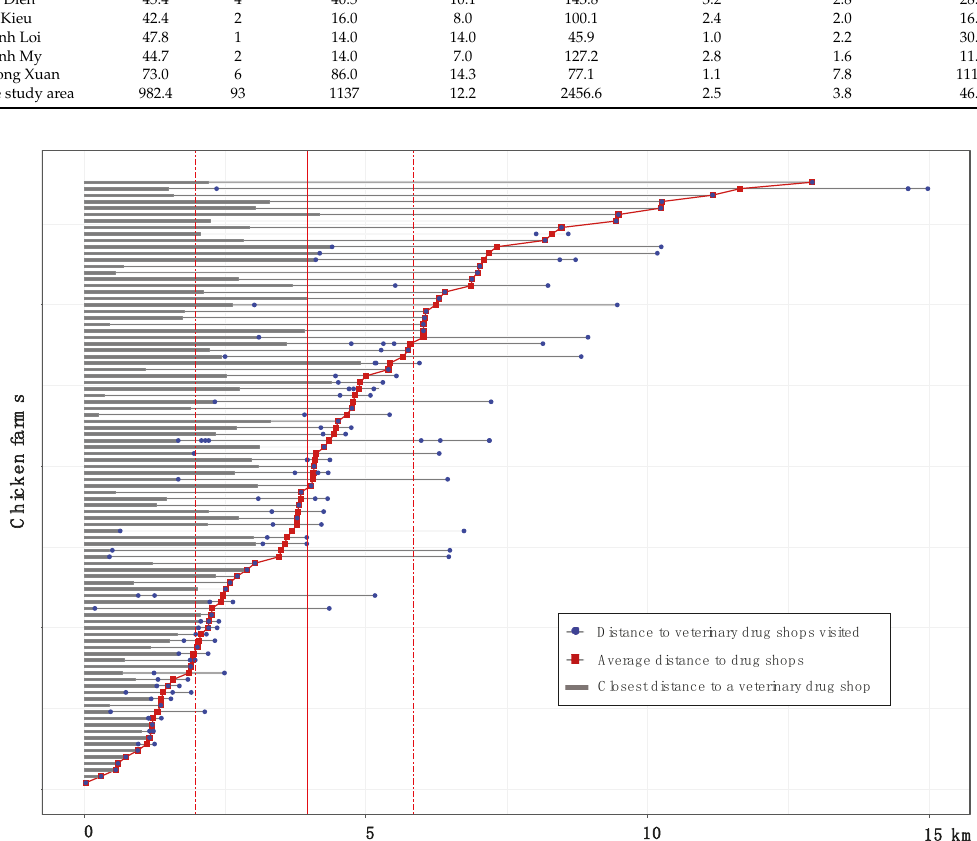
Figure 3. The geographical distance between farms ( n = 94), their closest veterinary drug shop, and the visited veterinary drug shops from which farmers purchased antimicrobials. Data from 2 farms were excluded, since farmers visited other districts to buy antimicrobials. Solid red line: The median distance between farms and visited shops (3.96 km); Dashed red lines: Inter quartile range [1.98–5.85].